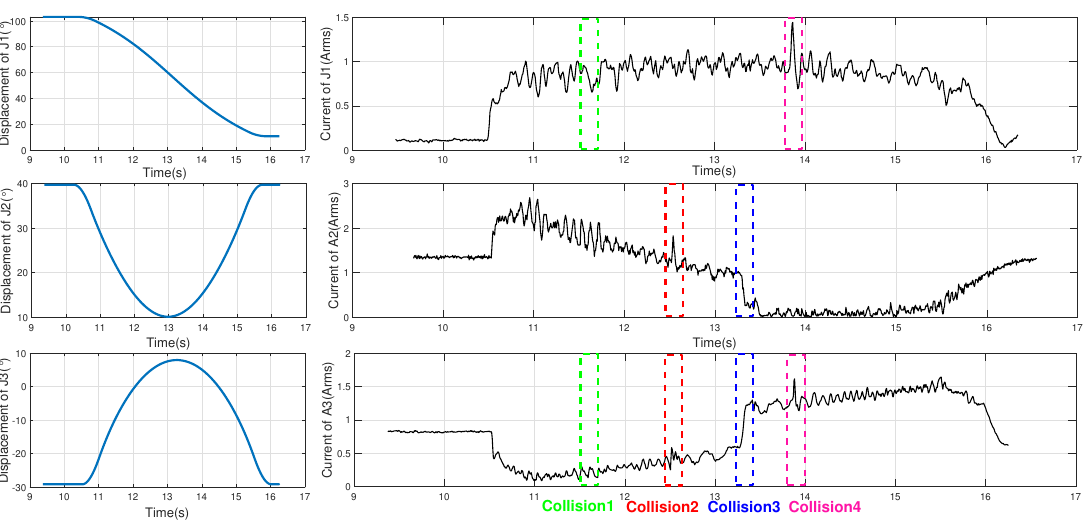
Figure 2. Joint displacement and current during the experiment.